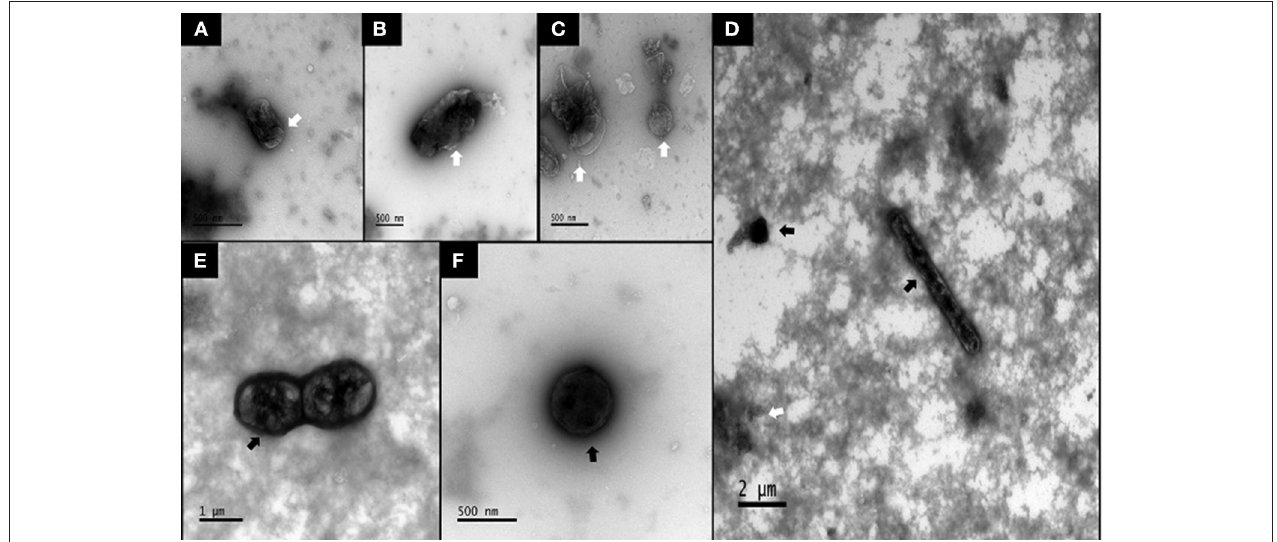
FIGURE 1 | TEM images of bacterial spores in SPORE and CON inocula. (A,B) , CON inoculum. (C–F) , SPORE inoculum. Atrophied or dead microbes are indicated by faint bodies with contorted outer membranes (white arrows). Spores or viable bacteria are seen as electron-dense (i.e., dark) with discernable membranes (black